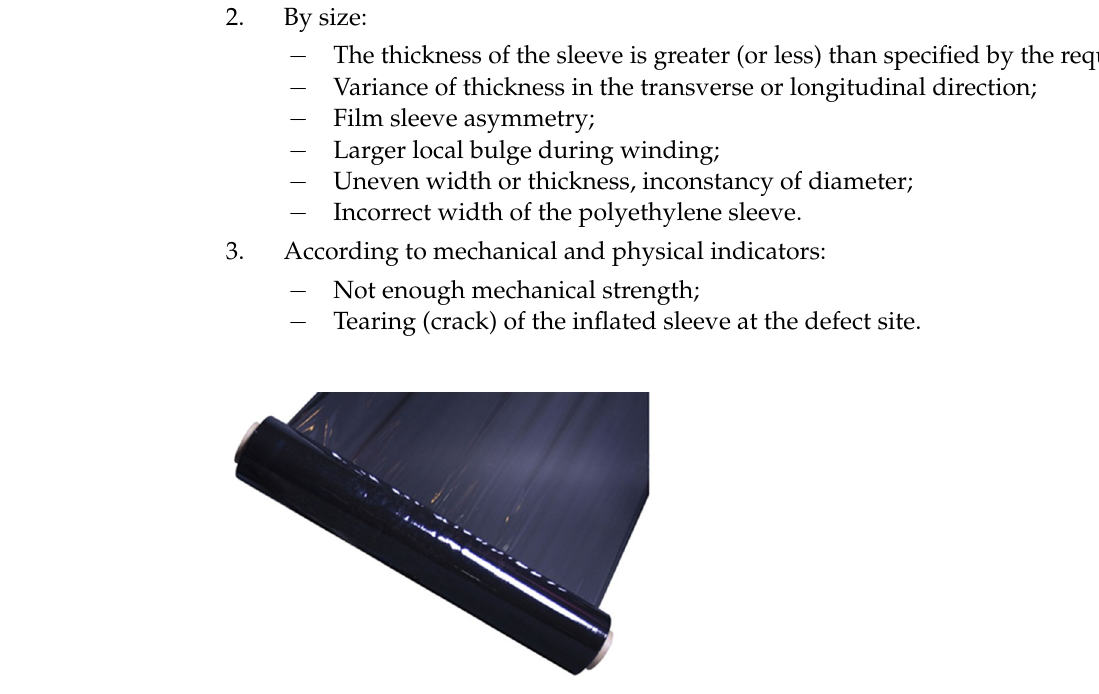
Figure 1. Longitudinal stripes.